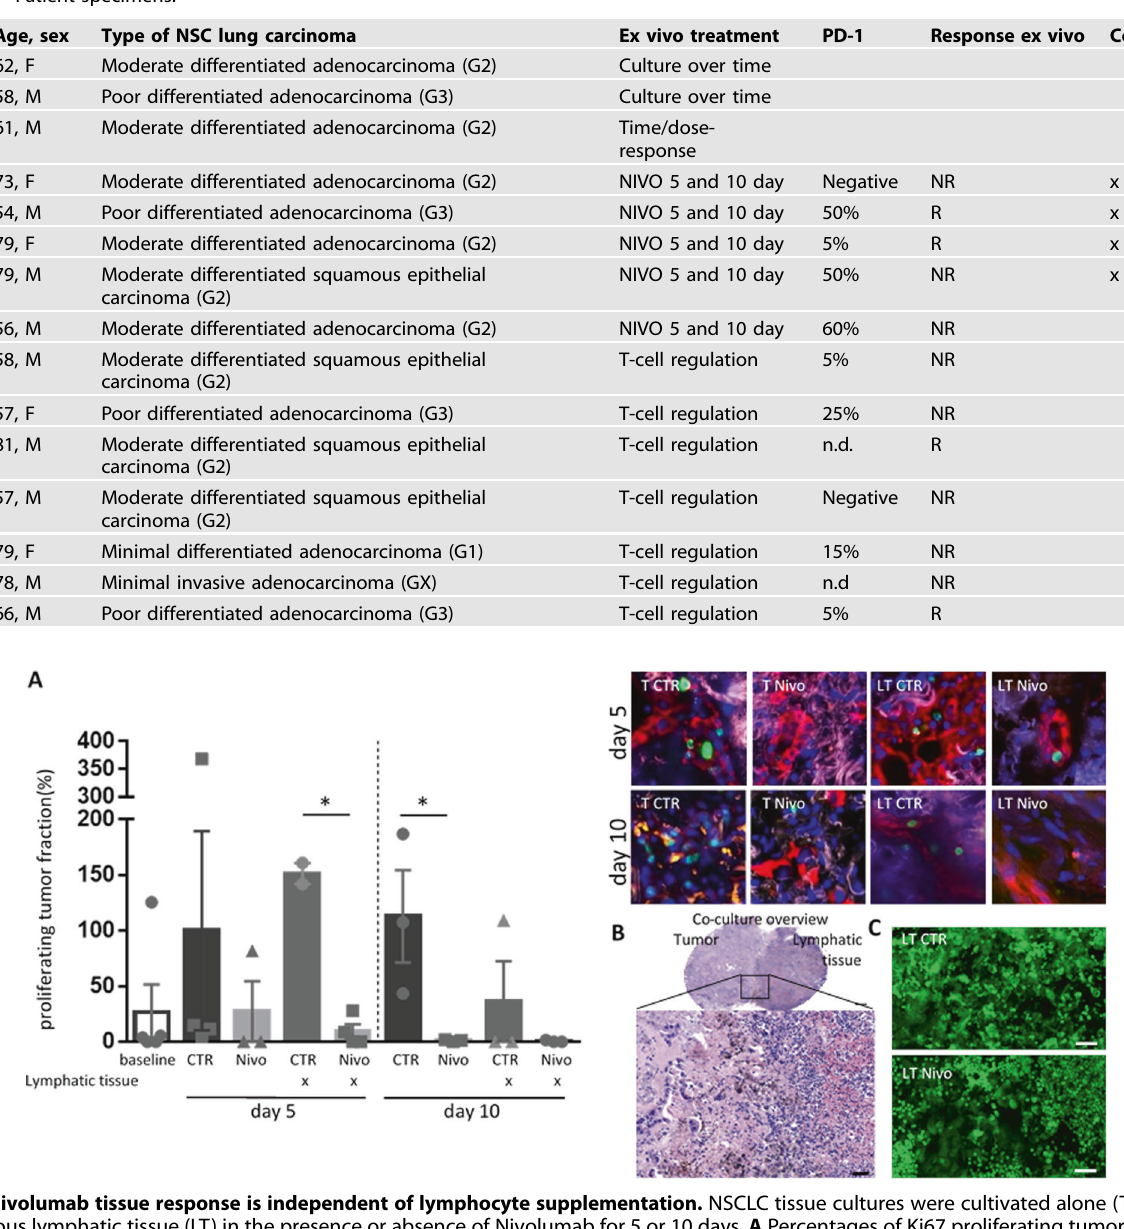
Table 1. Patient specimens.